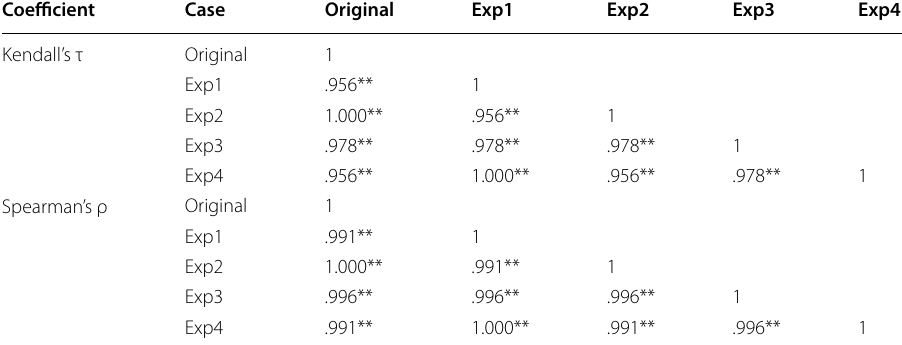
Table 17 Rank correlation test II